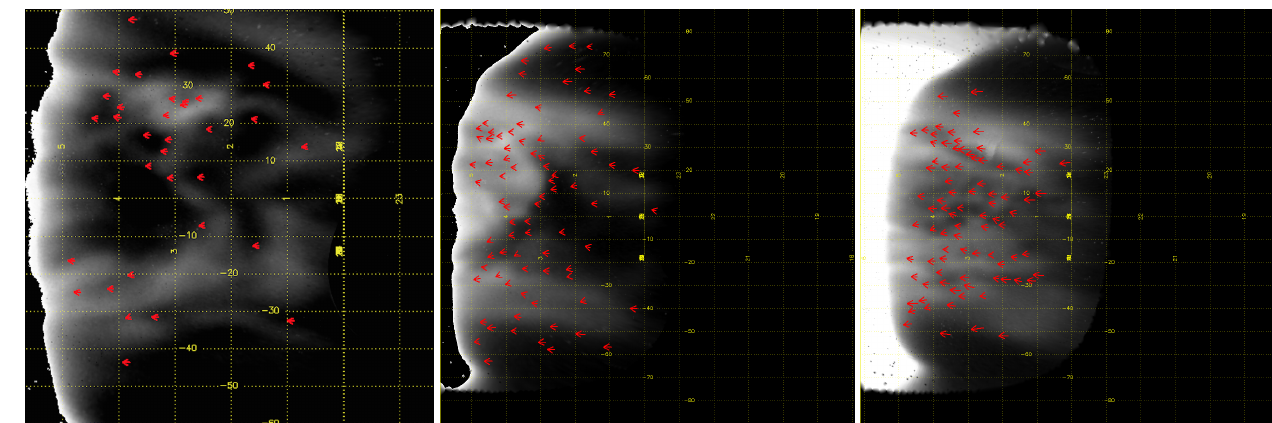
Figure 10. From left to right: examples of tracers marking the position of precise patterns in the clouds (opacity variability) from the observations from 11 to 13 July 2012 at